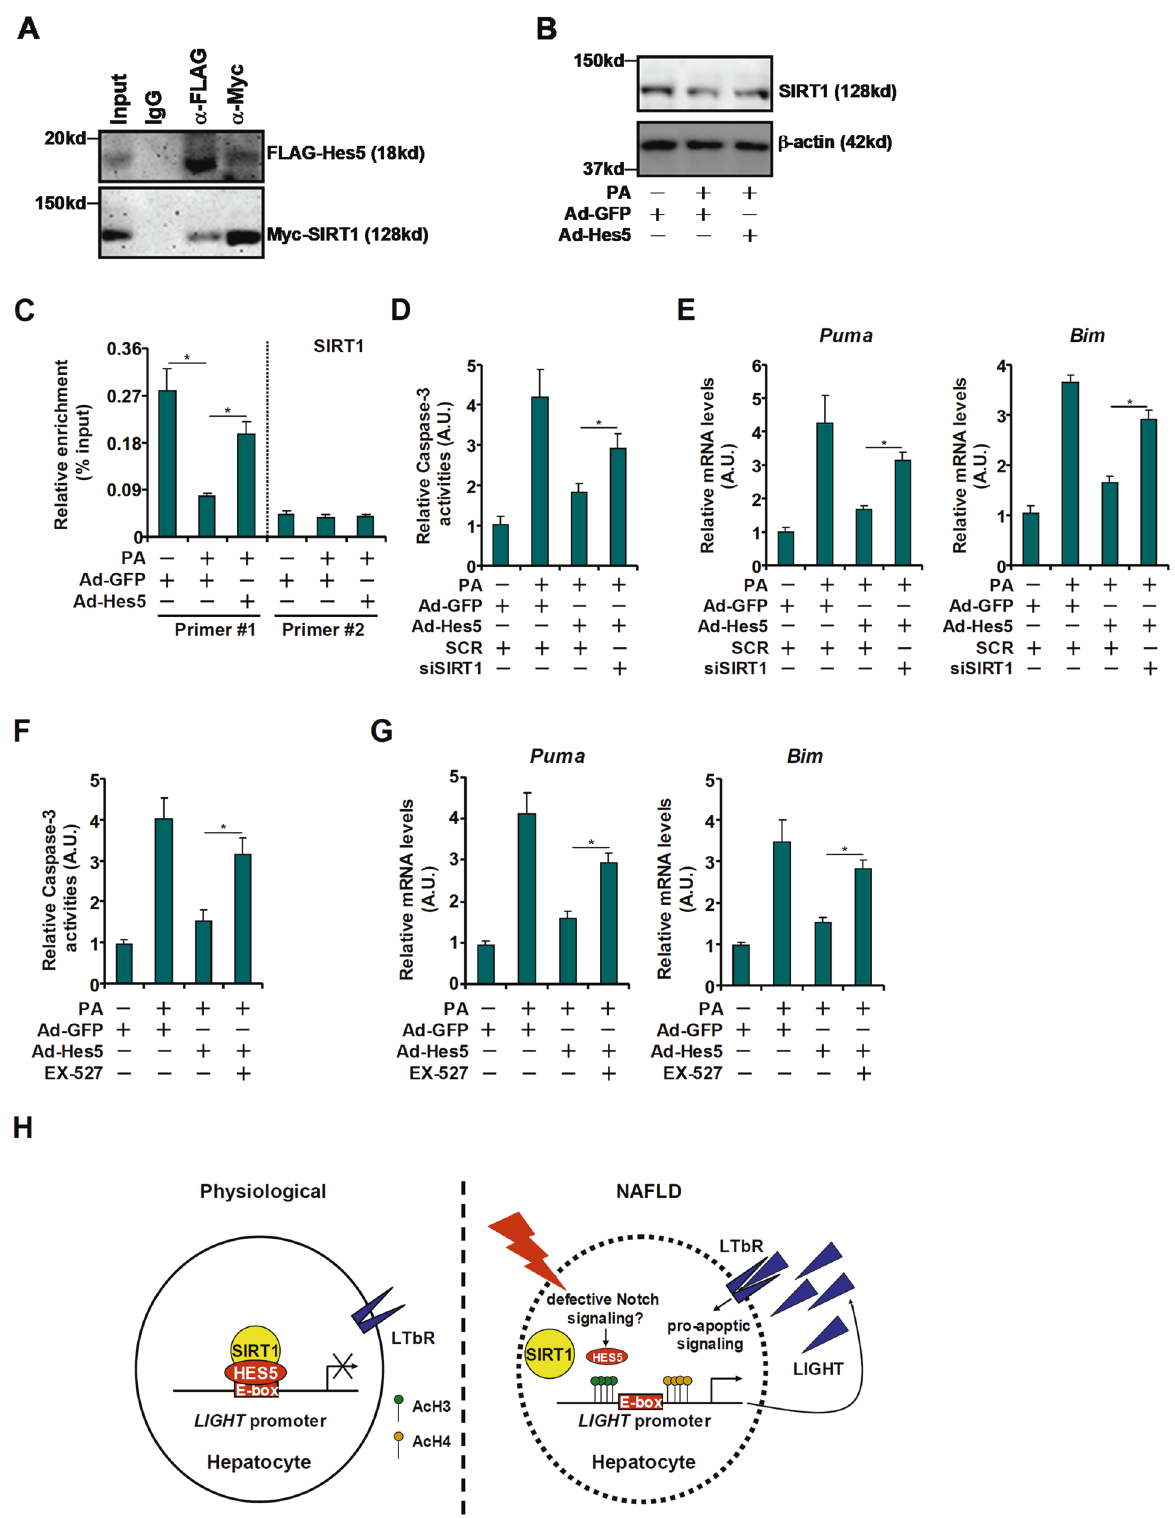
Fig. 5 HES5 interacts with SIRT1 to repress LIGHT transcription and antagonizes PA-induced apoptosis. A FLAG-tagged HES5 and Myc- tagged SIRT1 were co-transfected into HEK293 cells followed by immunoprecipitation with anti-FLAG, anti-MYC, or IgG. B , C Primary murine hepatocytes were transduced with Ad-HES5 or Ad-GFP followed by treatment with PA (0.3 mM). SIRT1 expression was examined by western. SIRT1 binding to the LIGHT promoter was examined by ChIP. D , E Primary murine hepatocytes were transduced with Ad-HES5 or Ad-GFP, transfected with siRNA-targeting SIRT1 or scrambled siRNA (SCR) and treated with PA (0.3 mM). Caspase-3 activity was measured by a fl uorescence kit as described in Methods. Gene expression was evaluated by qPCR. F , G Primary murine hepatocytes were transduced with Ad-HES5 or Ad-GFP followed by treatment with PA (0.3 mM) in the presence or absence of EX-527 (1 μ M). Caspase-3 activity was measured by a fl uorescence kit as described in Methods. Gene expression was evaluated by qPCR. H A schematic model. Cell Death Discovery (2021)